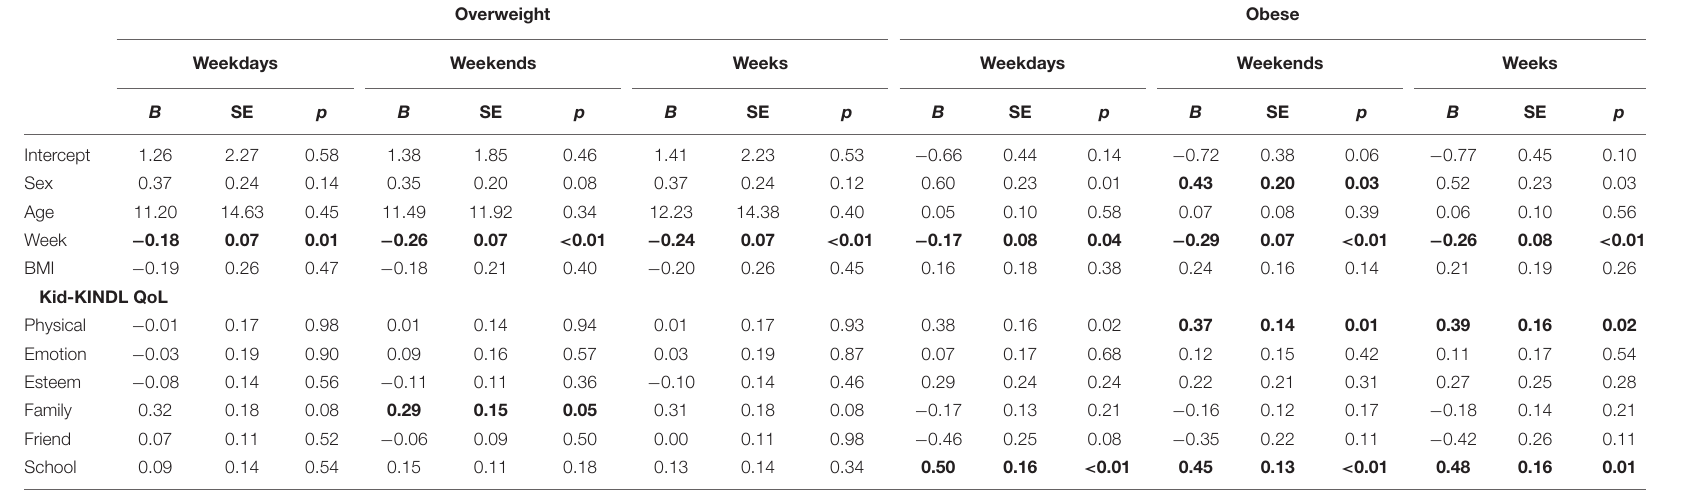
Bold values indicate being statistically significant at level of p <